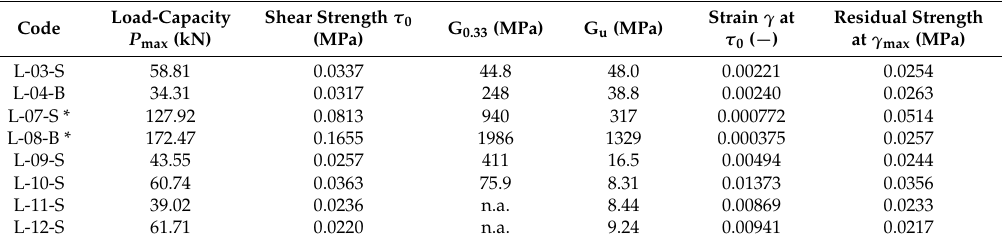
Figure 8. Shear tests carried out on panels cut off from Building No. 1 (non-rendered panels) and 2 (rendered panels): ( a ) Stone work panels; ( b ) Brickwork panels. Table 4. Results of shear tests. Table 4. Results of shear tests.